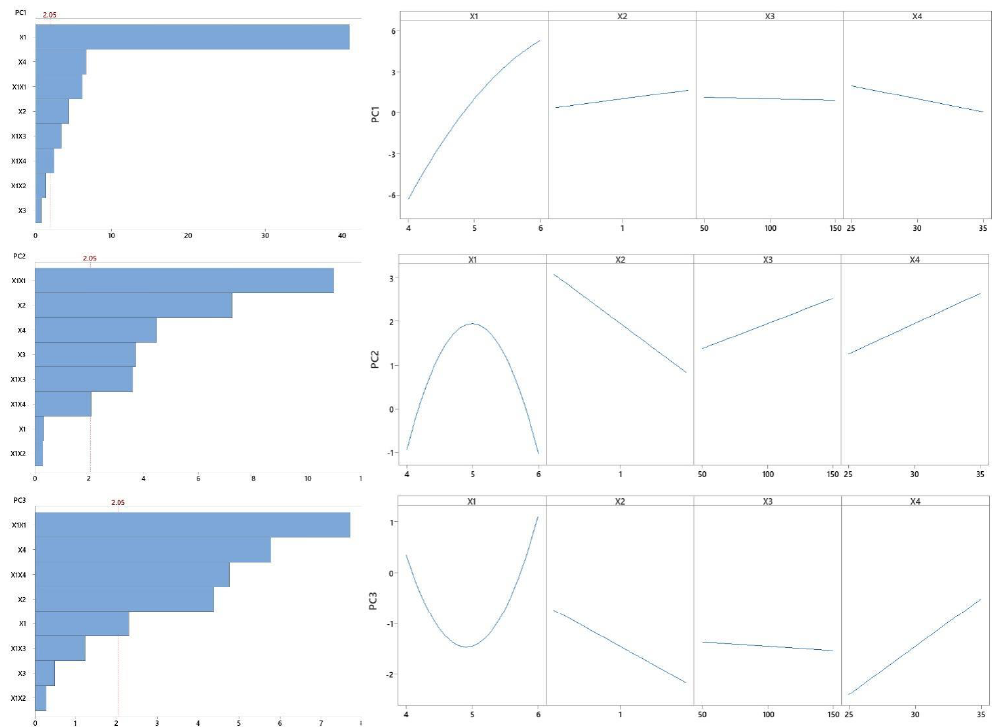
Figure 6. Pareto charts ( left ) and main effects plots ( right ) of the effect of the variables/factors (X1: pH, X2: Polydextrose, X3: Rotation speed, and X4: Temperature) on the responses (PC1, PC2, and PC3).